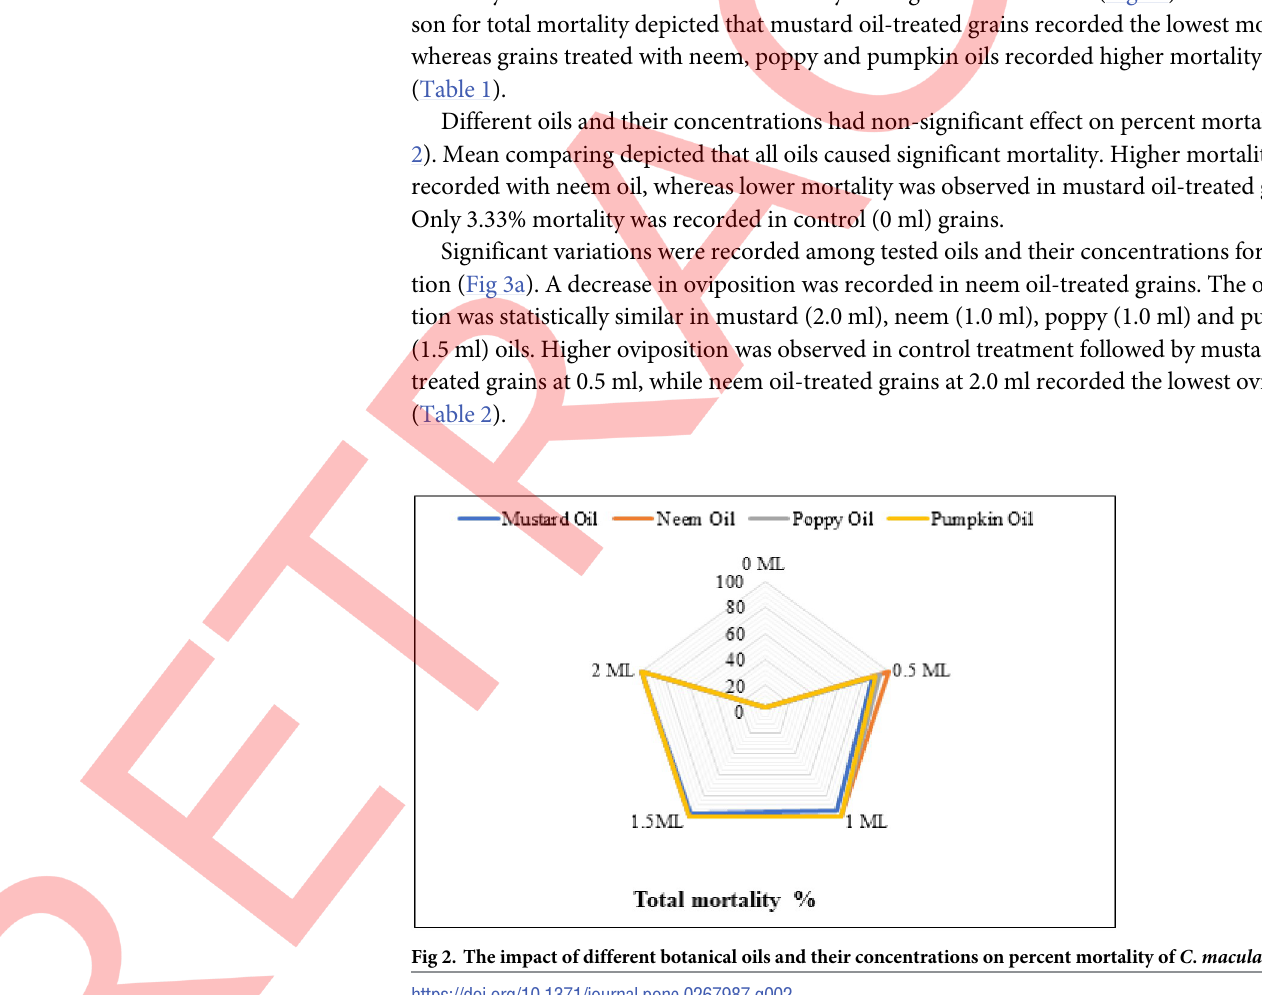
Fig 2. The impact of different botanical oils and their concentrations on percent mortality of C . maculatus .